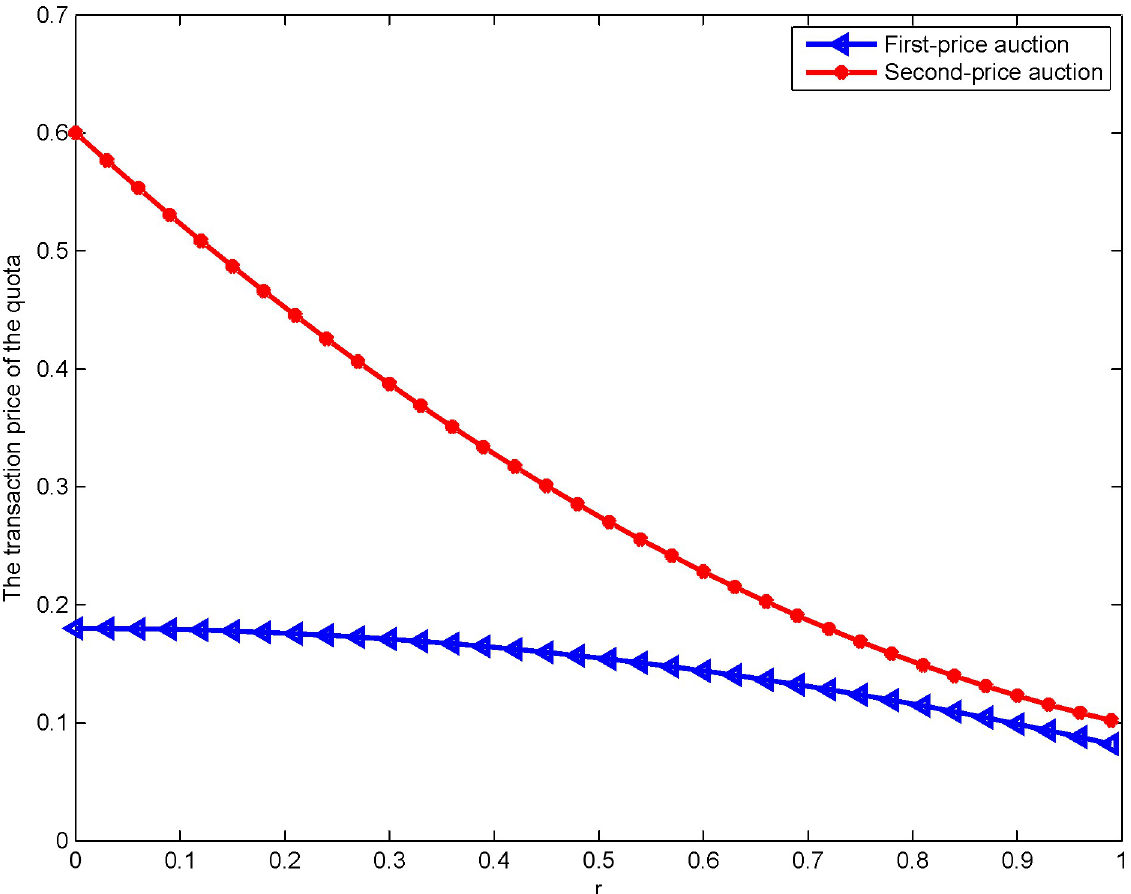
Fig 3. Impact of r on the transaction price of the L ; F j